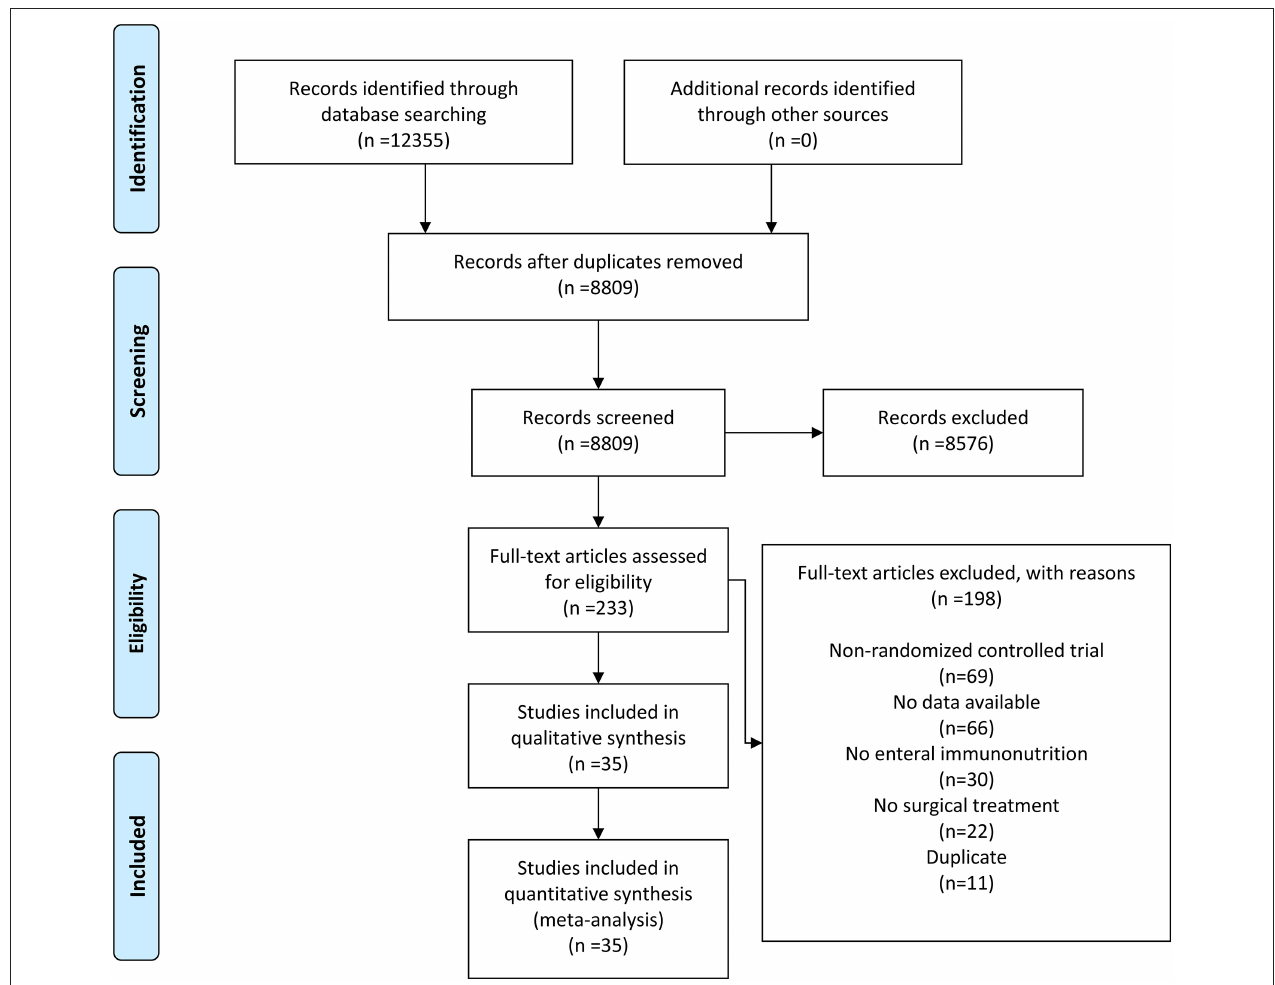
FIGURE 1 | Flow diagram of